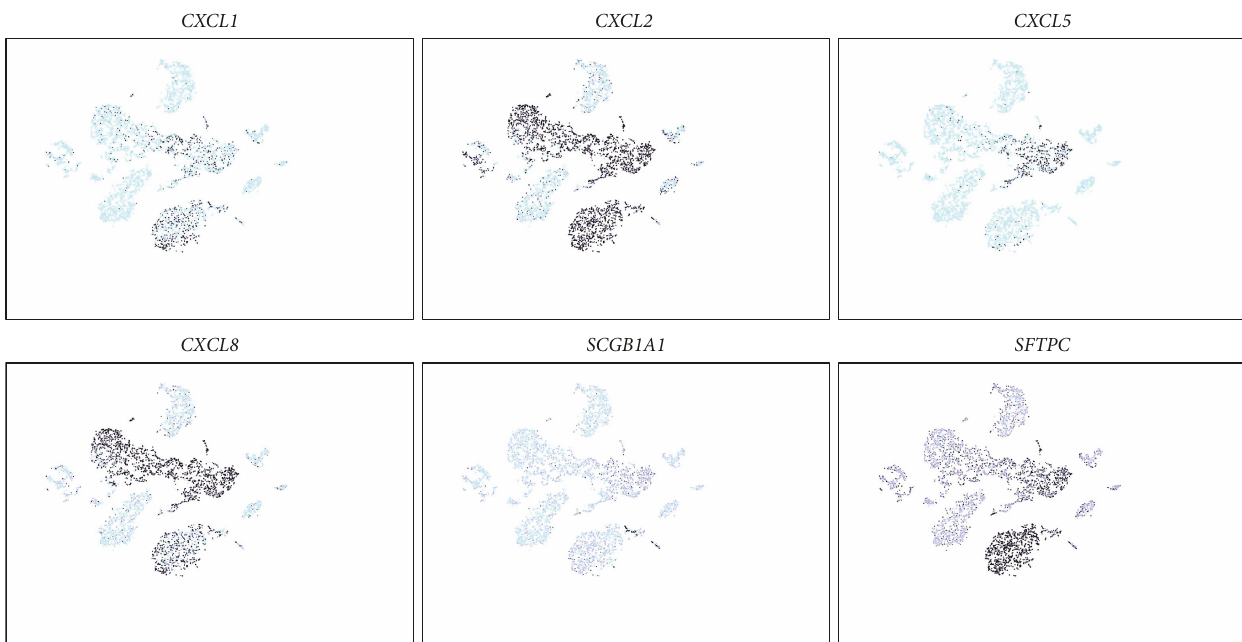
Figure 3: Human lung scRNA-seq. Cells were grouped into several clusters. The classi fi cation of speci fi c cell types was inferred from the annotation of cluster-speci fi c genes and based on expression of some well-known markers of certain cell types. CXCL1 , CXCL2 , CXCL5 , CXCL8 , SCGB1A1 , and SFTPC expression cells were displayed in the cell population separately. The darker the color the cell was labelled, the higher mRNA level of target gene the cell had (the light green cells were the ones without the target gene